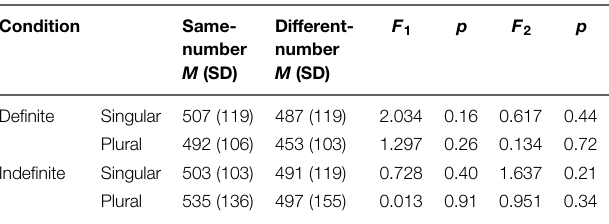
TABLE 3 | Experiment 2 RT analyses.